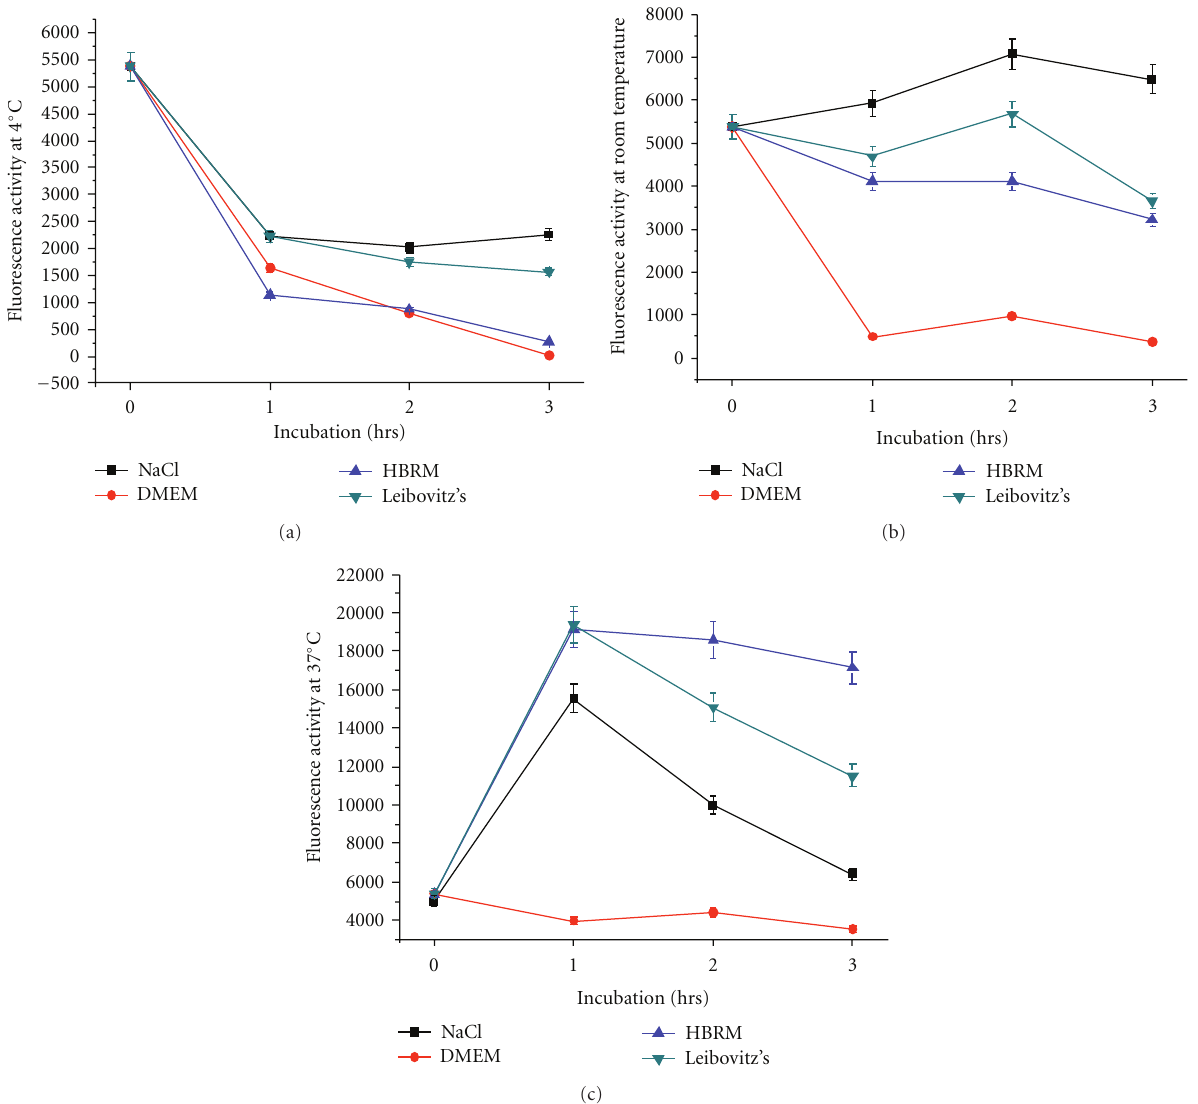
Figure 2: This Figure and respectively, Figure 3: Schwann cell metabolism indicated as fluorescence activity at 4 ◦ C (a), room temperature (b), and at 37 ◦ C (in (c)) incubated in the described media. Cell viability was measured by reduction of resazurin to resofurin by CellTiter- Blue (CTB) Cell Viability Assay. Most reduced cell viability was observed after 3-hour incubation of Schwann cells in DMEM at 4 ◦ C. Optimal cell viability with increase of Schwann cell metabolism can be seen after incubation in HBRM at 37 ◦ C. P < 0 .